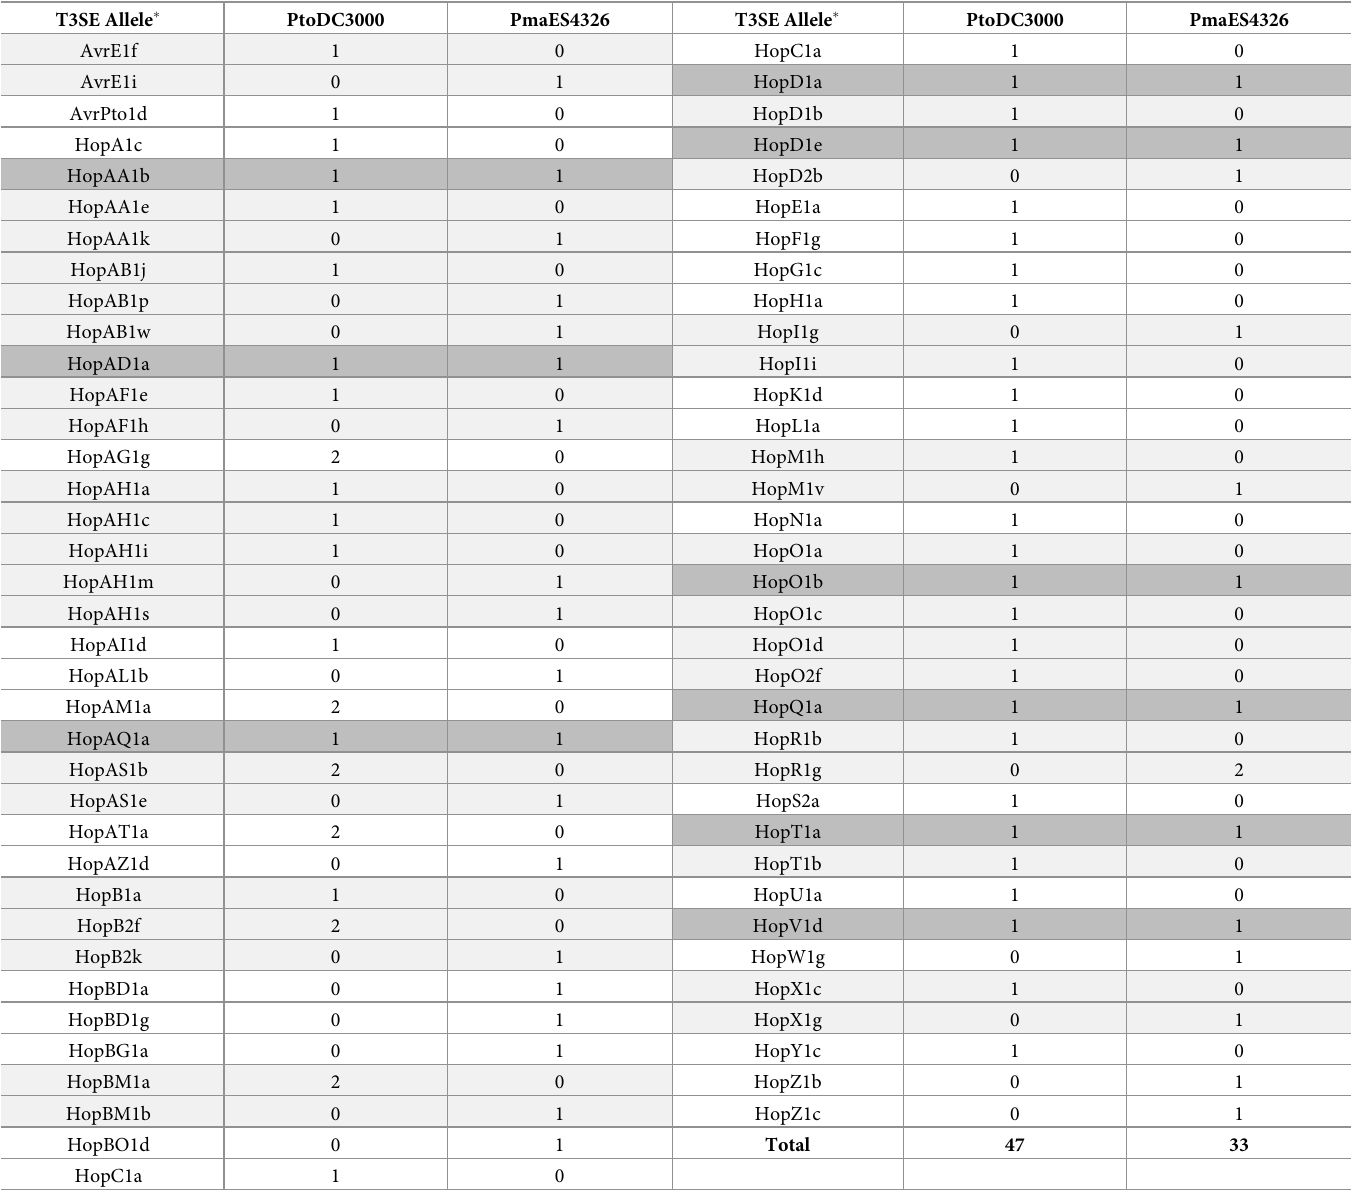
Table 1. PtoDC3000 and PmaES4326 native T3SE